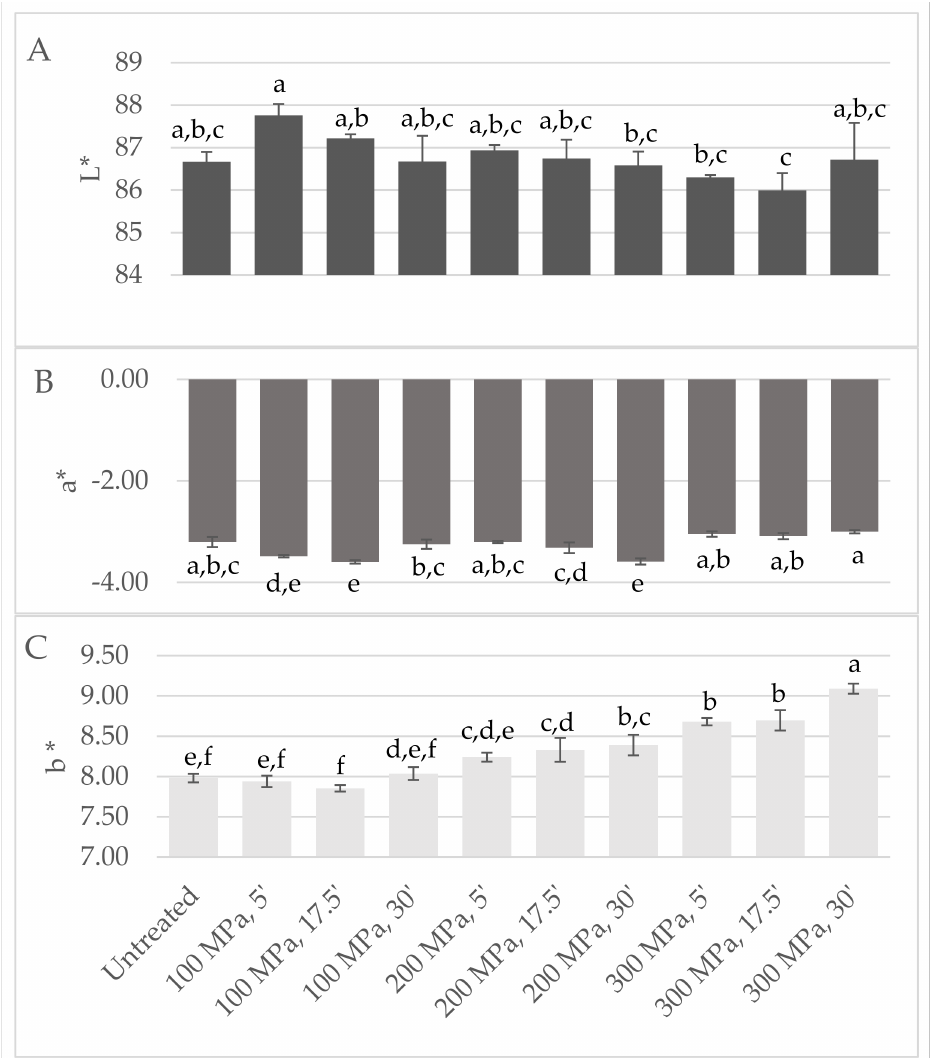
Figure 4. Design of experiment results: colour CIE ( A ) L* , ( B ) a* and ( C ) b* parameters measured in milk high-pressure processing (HPP) treated according to central composite design. Different non-capital letters (a, b, c, d, e, f) indicate statistically significant differences between the different conditions ( p <